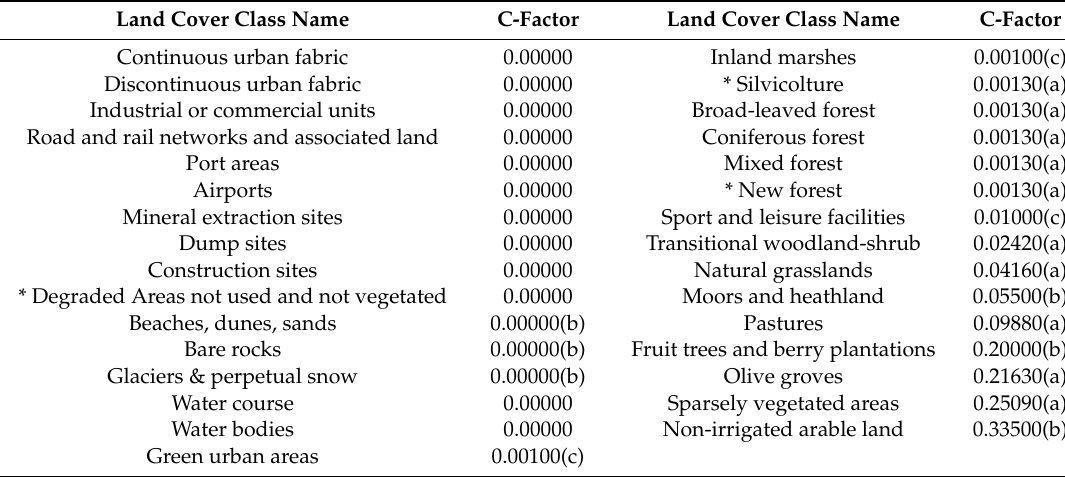
Table 2. Tabulated values of C-factor used. C-factor values sources are (a) the parametrization proposed for Italy by [48], the central value of the C-factor range values for Europe from (b) [48], (c) [49]. * not in Corine Land Cover